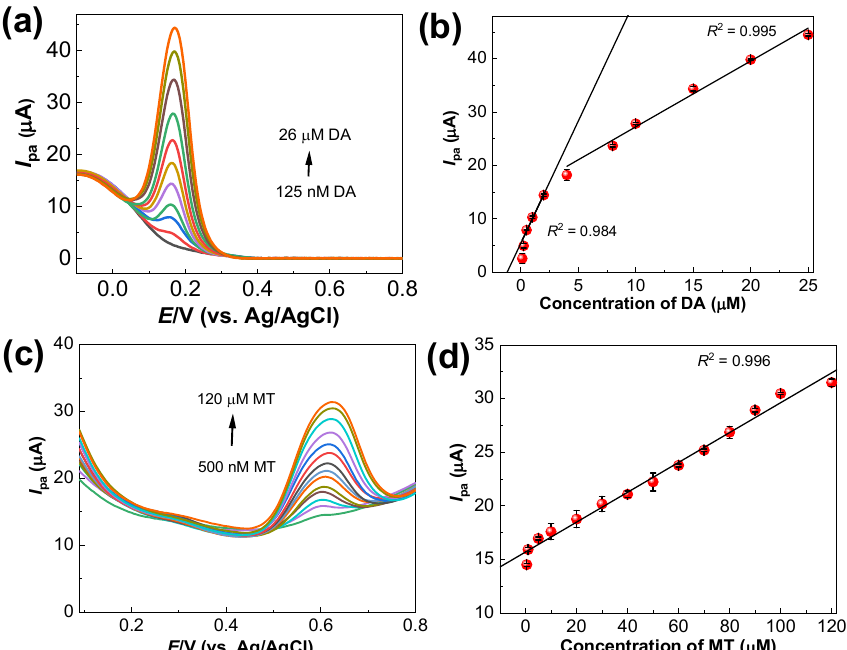
Figure 8. ( a ) DPV responses of the Cu–CNS/SPCE in different DA concentrations (125 nM to 26 μM), ( b ) DA calibration plot in two linear concentration ranges (125 nM to 4.0 μM) and (5.0 to 26.0 μM), ( c ) DPV responses against different MT concentrations (500 nM to 120 μM), and ( d ) calibration plot of MT in a wide linear range from 500 nM to 120 μM.